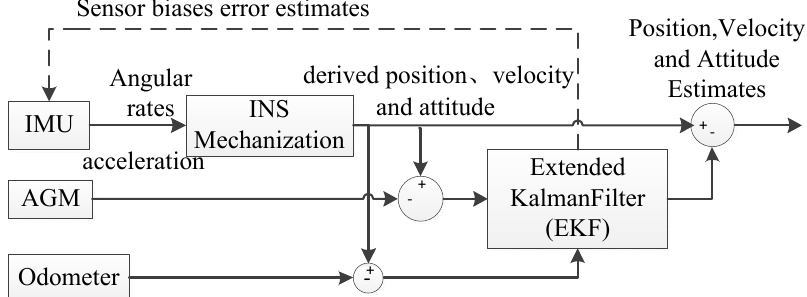
Figure 3. Centerline calculation based on multi-sensor data fusion algorithm. IMU—inertial measurement unit; INS—inertial navigation system; AGM—above-ground marker.